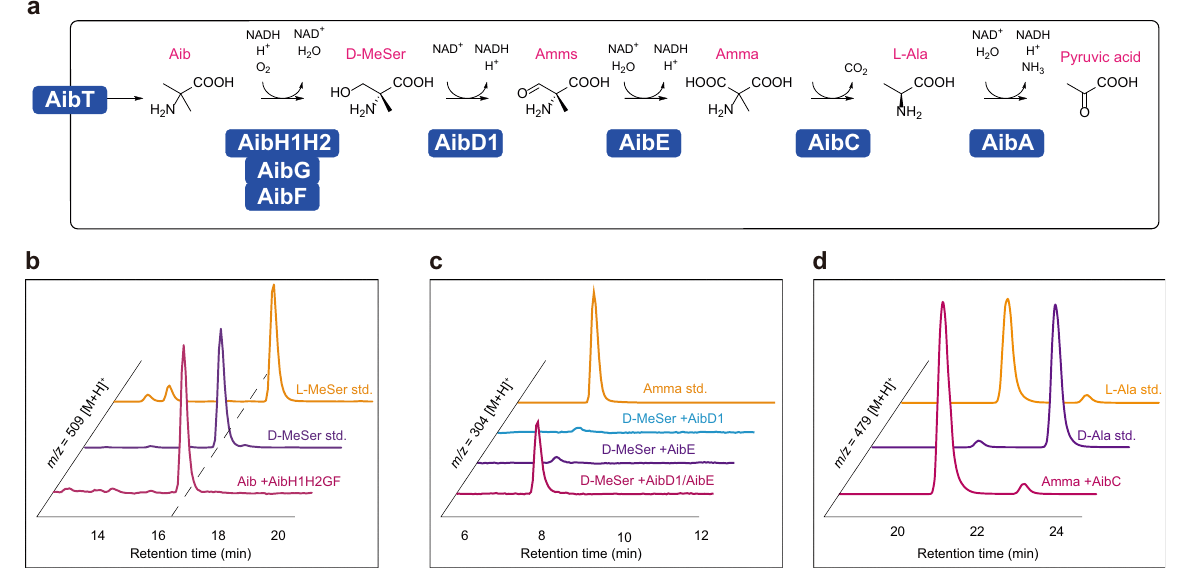
Fig. 2 Elucidated Aib-catabolic pathway in R. wratislaviensis C31-06. a Aib is degraded into pyruvic acid via a fi ve-step enzymatic reaction. b A chiral HPLC analysis of D -MeSer produced from reactions catalyzed by AibH1H2GF. The m/z 509 [M + H] + represents a mass to charge ratio of D / L -MeSer derivatized with GITC. c Analyses of products from the reactions catalyzed by AibD1 and AibE. AccQ derivative of Amma indicated m/z 304 [M + H] + . d Stereoselective Amma decarboxylation activity of AibC. Alanine formed in the Amma decarboxylation reaction mixtures was analyzed by chiral amino acid analysis. The m/z 479 [M + H] + represents a mass to charge ratio of D / L -Ala derivatized with GITC.